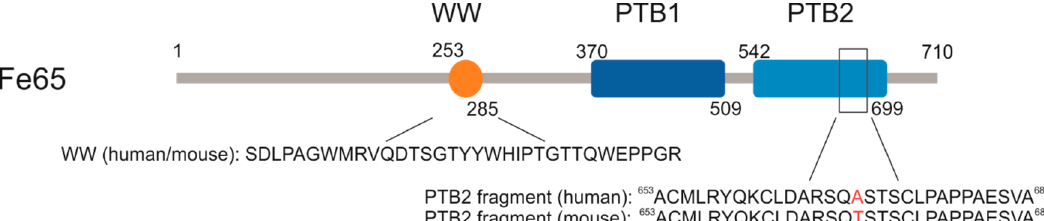
Figure 1. Human (Uniprot: O00213) and mouse (Uniprot: Q9QXJ1) domain structures of Fe65. WW (tryptophan, tryptophan) protein interaction domains are the same in human and mouse Fe65; PTB2 (phosphotyrosine-binding) domains differ only in one amino acid at position 668.